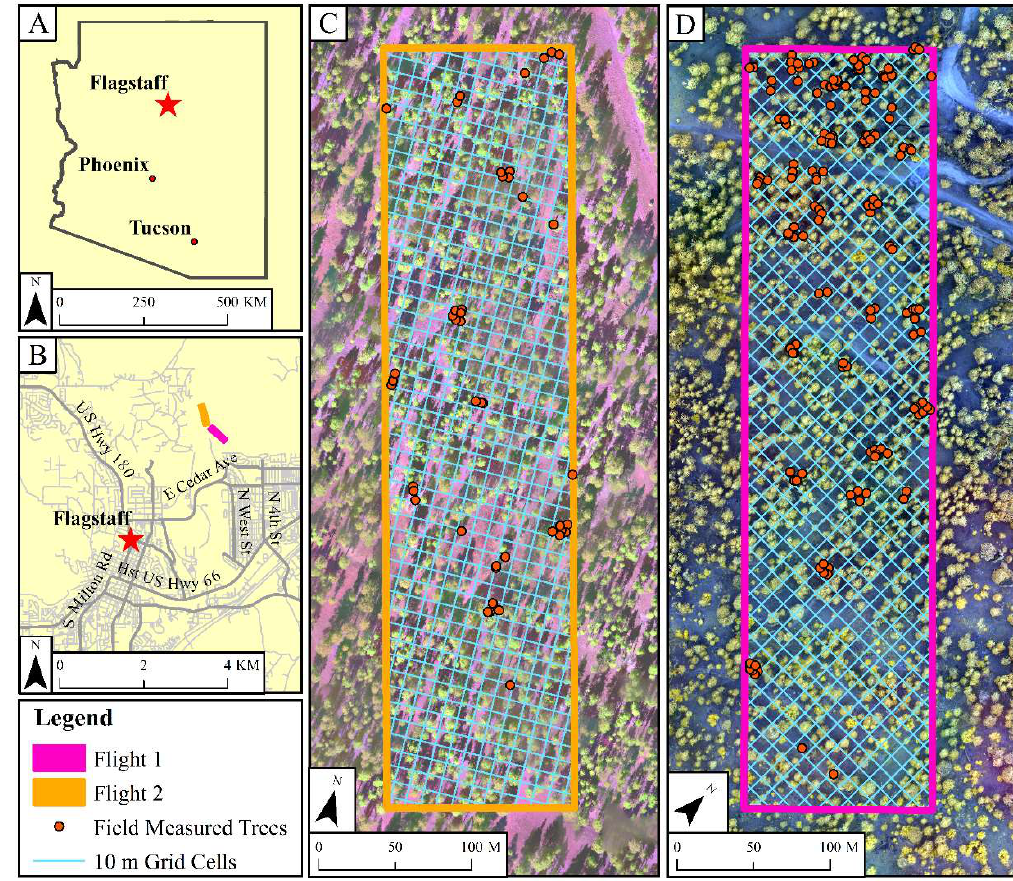
Figure 1. Vicinity map of our study site, UAV flight areas, and field sampling locations: ( A ) Location of our study area in within the state of Arizona, ( B ) UAV flight locations and their proximity to Flagstaff, Arizona, USA, and ( C , D ) Both UAV flight areas overlaid on false color UAV imagery with points representing each field measured tree.